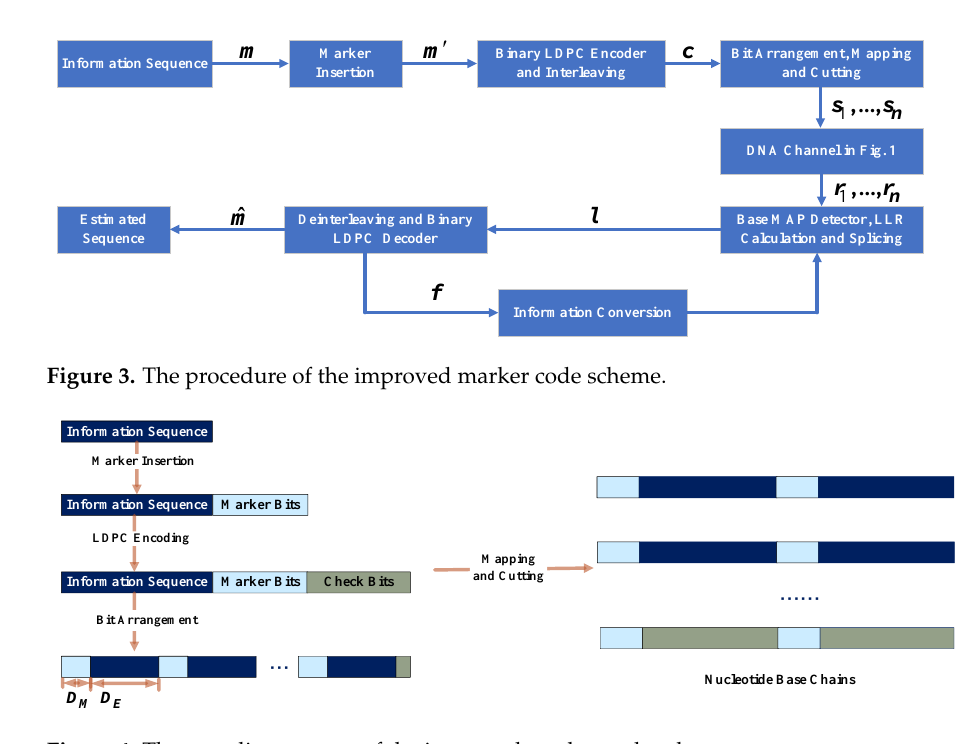
Figure 4. The encoding process of the improved marker code